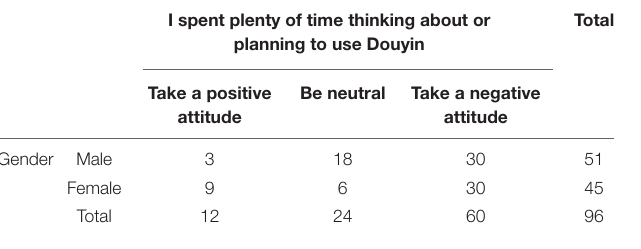
TABLE 1 | Cross-sectional analysis of gender and addiction degree. TABLE 2 | Cross-sectional analysis of age group and addiction